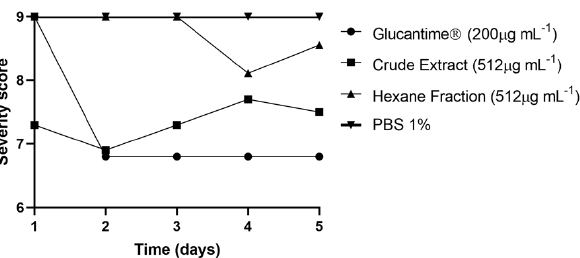
Figure 5. Evaluation of severity score of Tenebrio molitor larvae treated with crude extract or hexane fraction of Vernonanthura brasiliana (L.) H. Rob and leishmanicidal reference drug Glucantime ® . The difference between the tested groups was considered significant when p < 0.05 using two-way ANOVA.